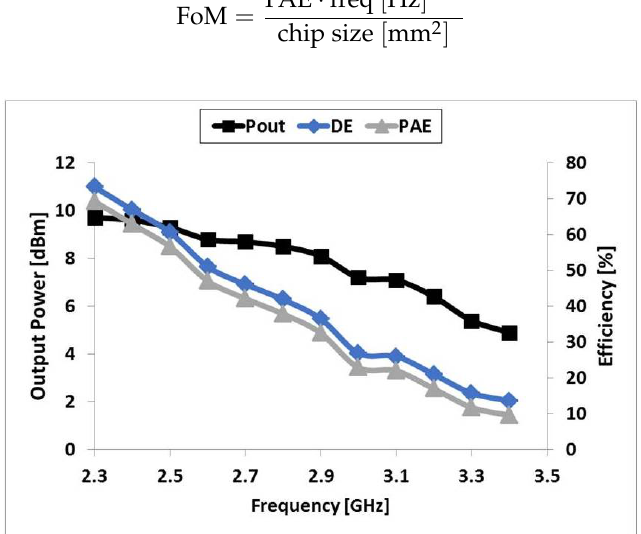
Figure 10. Transformer-based class-E PA: Measured output power, drain efficiency and power-added efficiency versus operating